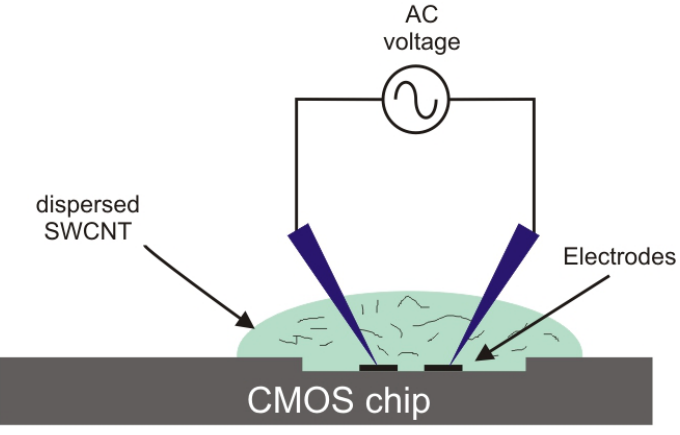
Figure 3. Scheme of the SWCNTs deposition by DEP process.